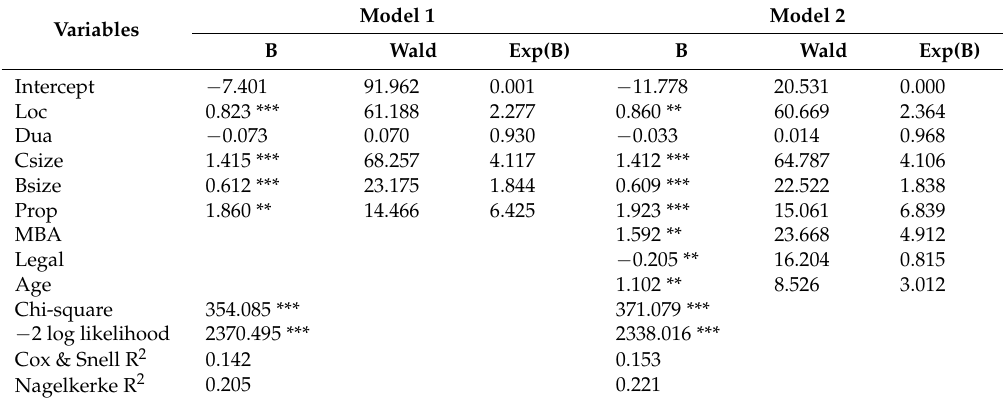
Table 2. Regression results.